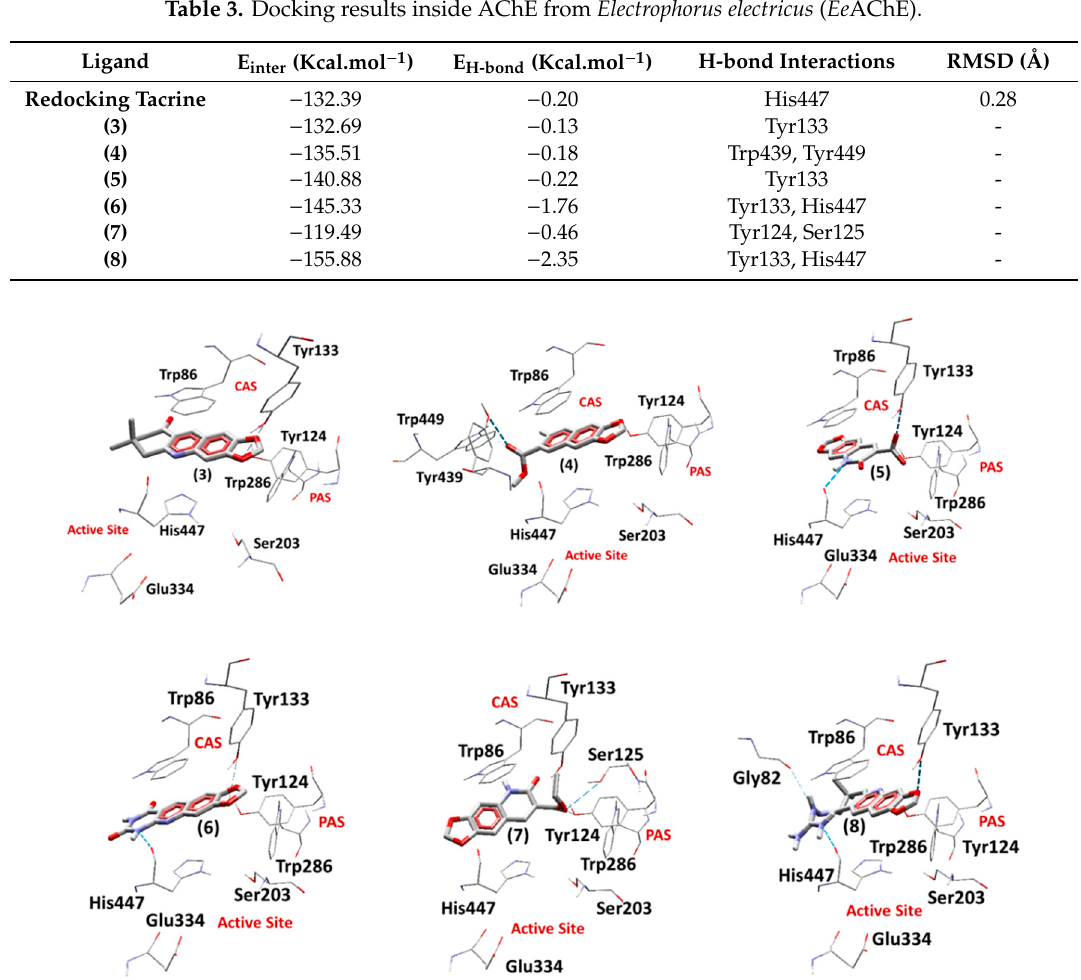
Figure 4. Best docking poses of the ligands inside Ee AChE.